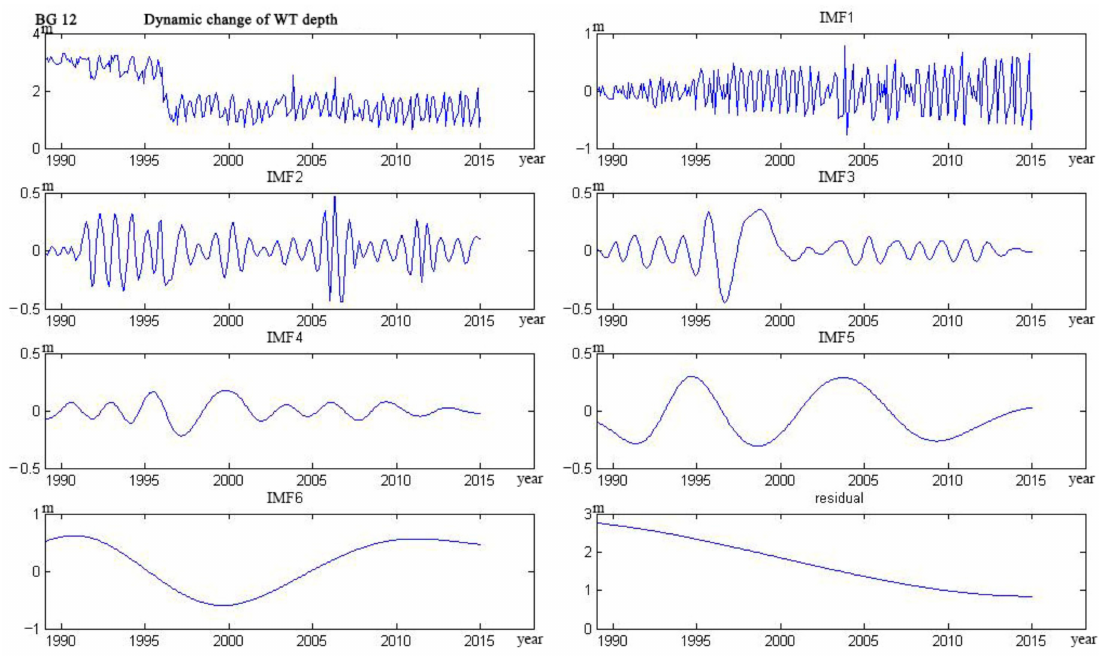
Figure A9. Decomposition of groundwater time series data of well BG12.